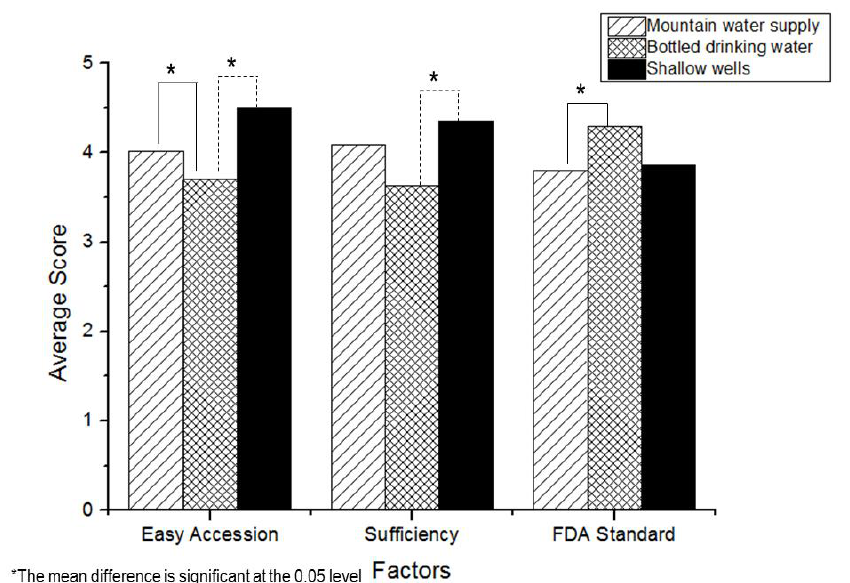
Figure 3. Comparison of tree influencing factors of drinking water.